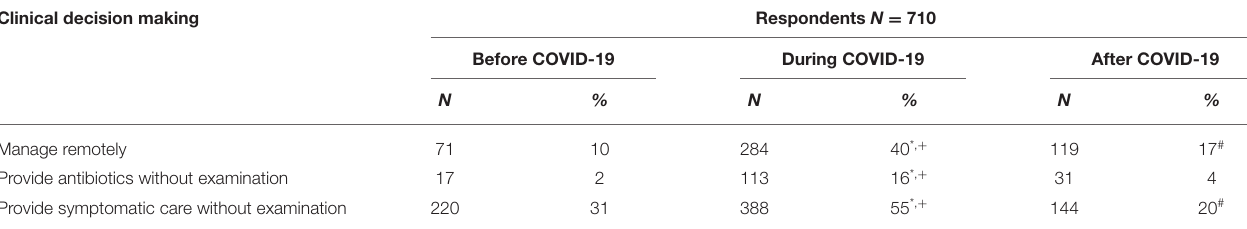
TABLE 4 | High likelihood pattern of clinical decision making in scenario 2. Clinical decision